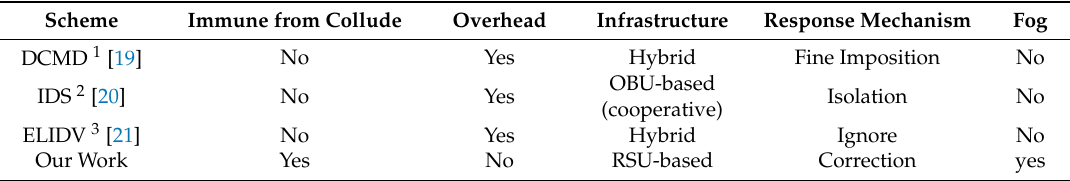
Table 5. Comparison with other misbehavior detection schemes.